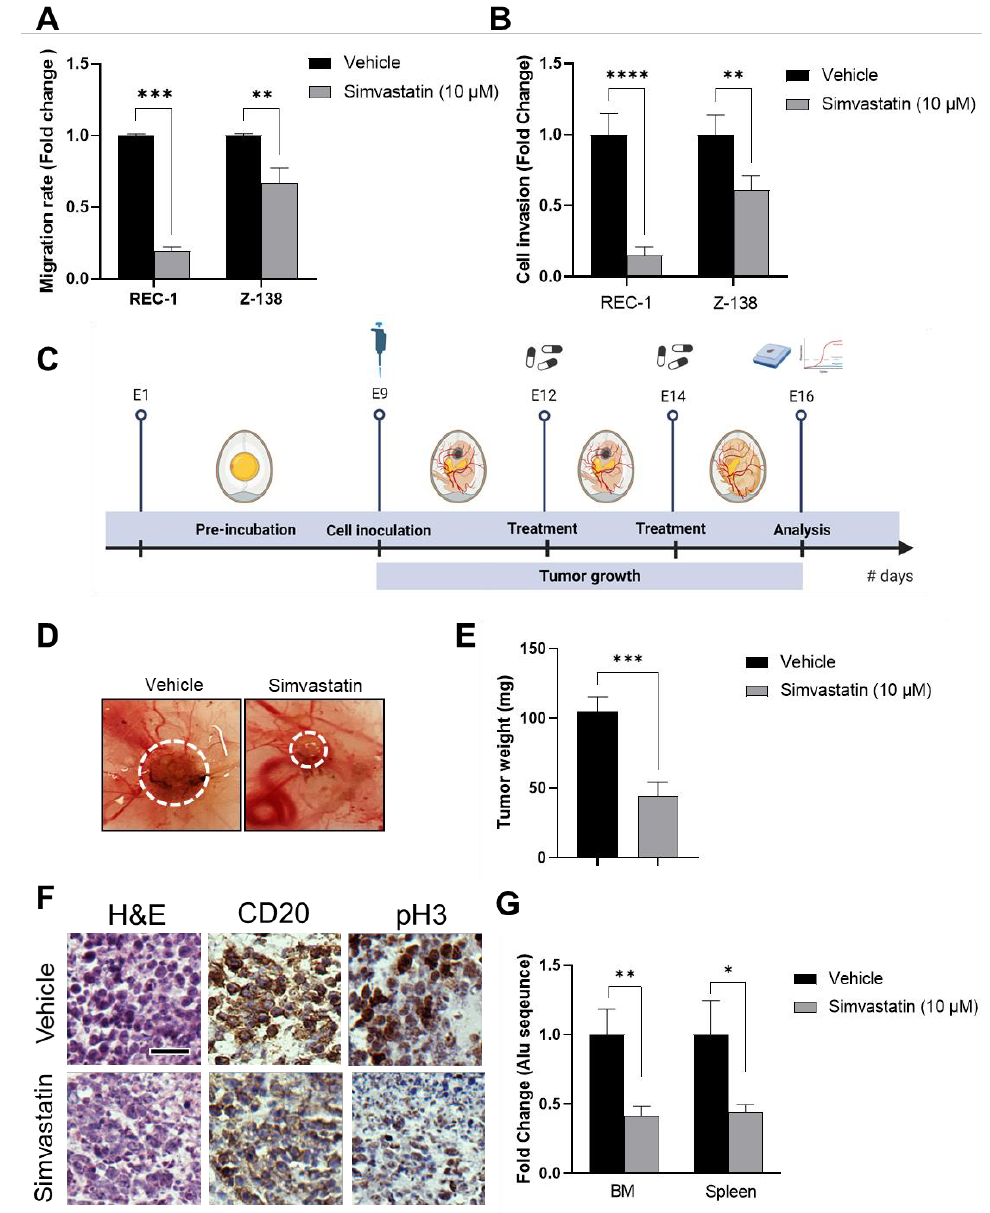
Figure 2. MCL migration and invasion ability, tumor growth and metastasis inhibited by simvastatin treatment. ( A ) Cell migration index of MCL cell lines exposed to 10 µ M of simvastatin or vehicle for 24 h; ( B ) cell invasion index of MCL cell lines exposed to 10 µ M simvastatin or vehicle for 24 h; ( C ) scheme depicting the chick embryo chorioallantoic membrane (CAM) model; ( D ) representative pictures of engrafted MCL tumors treated with 10 µ M simvastatin or vehicle on day 16 of embryonic development. The dotted line delimitates the tumor; ( E ) tumor weight on day 16 of embryonic development after the treatment with 10 µ M simvastatin or vehicle; ( F ) H&E and immunohistochemical (IHC) detection of CD20 and H3-pSer10 in tissue sections from CAM-tumor specimens dosed with 10 μM simvastatin or vehicle; ( G ) metastasis evaluation measured by qPCR-based Alu- sequence presence into embryo’s bone marrow and spleen. Values are expressed as mean ± SEM. * p < 0.05, ** p < 0.01, *** p < 0.001, when compared to the control group.